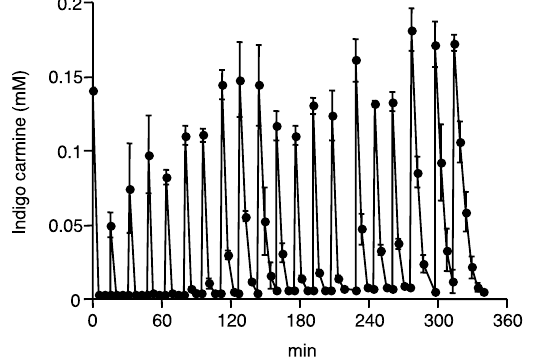
Figure 3. Successive decolorization of Indigo Carmine by IOX. The reaction mixture contained 10 mU mL − 1 of IOX, 0.15 mM Indigo Carmine, 0.1 mM iodide, and 20 mM sodium acetate buffer (pH 5.5). After complete decolorization, 0.15 mM of Indigo Carmine was sequentially added to the reaction mixture a total of 20 times. The molar absorption coefficients of Indigo Carmine were determined in 20 mM sodium acetate buffer (pH 5.5), and 13.3 mM − 1 ·cm − 1 was used for quantification.